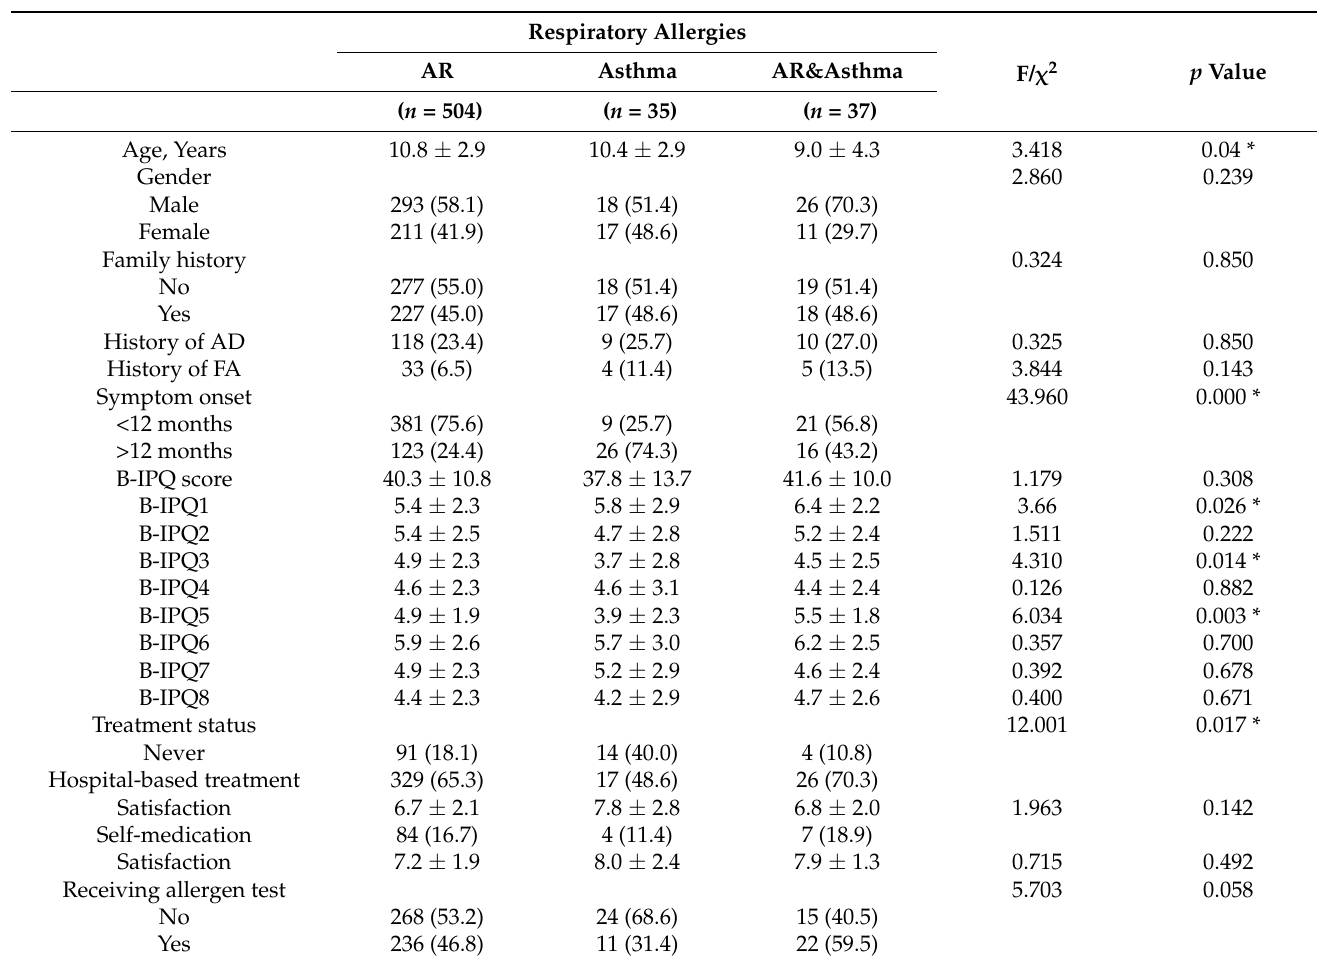
Table 1. Descriptive characteristics of the patients with respiratory allergies ( n = 576).